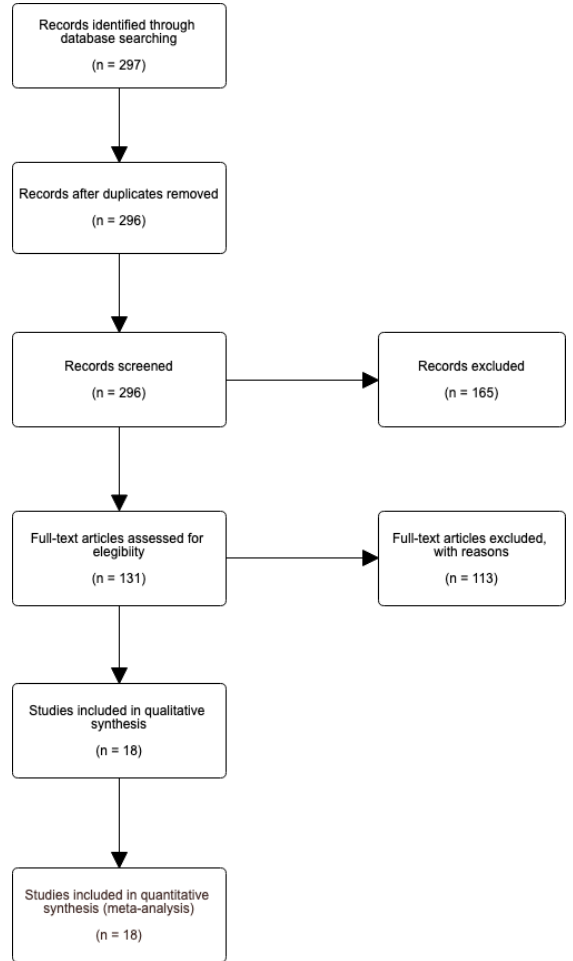
Figure 1. Flow diagram of identification and inclusion of